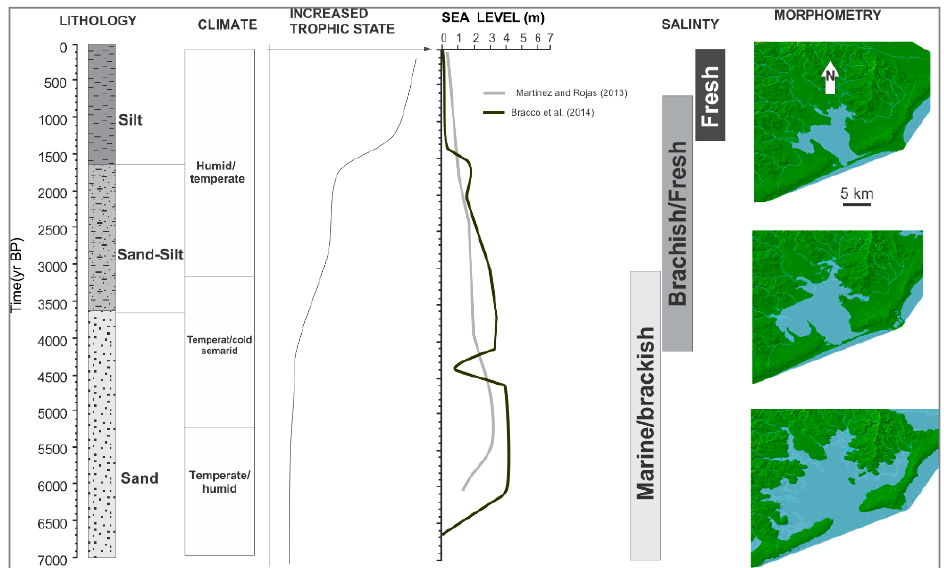
Figure 3. Holocene evolution of Laguna de Rocha (LR) in relation to sea level variation and climate. Note the Holocene increment in the trophic state in relation to salinity and sea level changes (morphometry taken from [24]; climate taken from [25]).